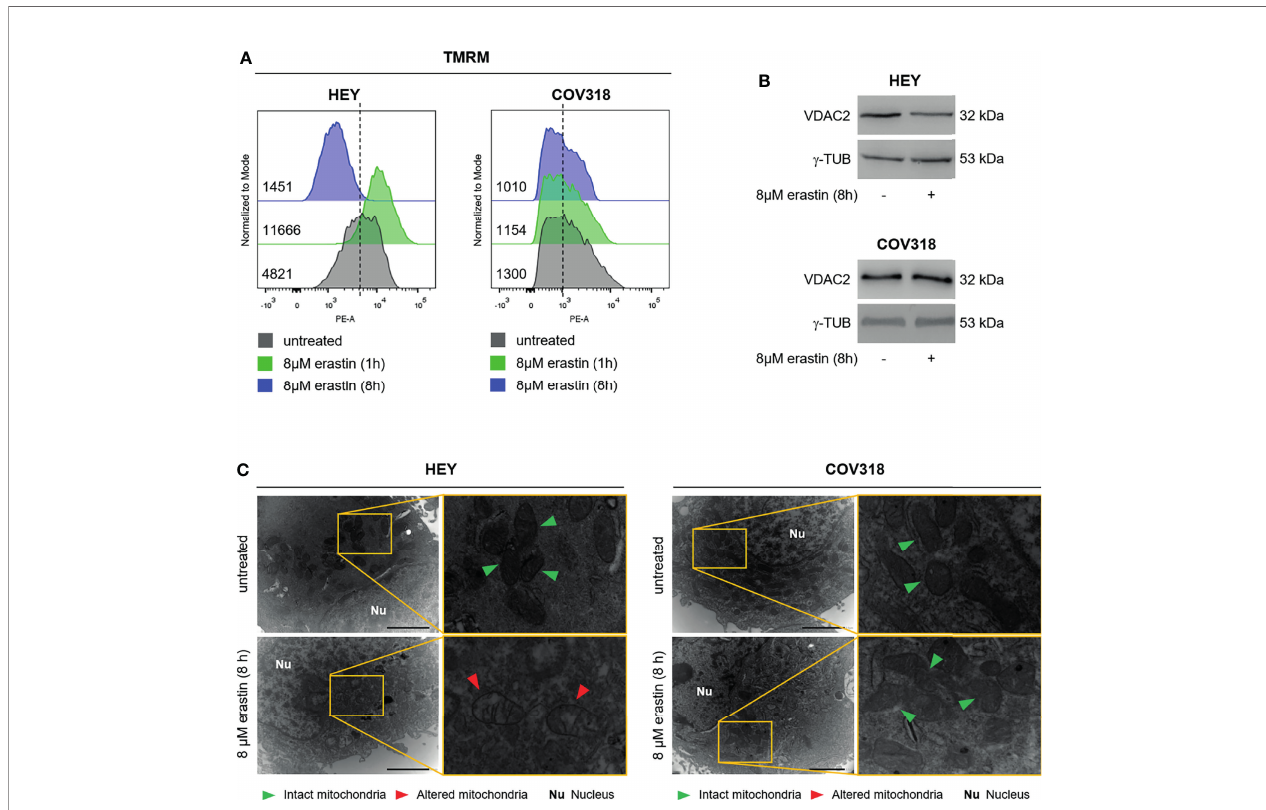
FIGURE 3 | Erastin treatment triggers mitochondrial dysfunction in HEY cells. (A) Mitochondrial membrane potential measured by TMRM fl ow cytometry assay in HEY and COV318 cells untreated or treated with 8 µM erastin for 1 and 8 h. (B) Western Blot of VDAC2 in HEY and COV318 cells upon administration of 8 µM erastin for 8 h. g -TUB was used as a normalization control for protein quanti fi cation. (C) Mitochondrial ultrastructural images detected by TEM of HEY and COV318 cells treated with or without 8 m M erastin for 8 h. Green arrows, intact mitochondria; red arrows, altered mitochondria; Nu, nucleus. Results are representative of three independent